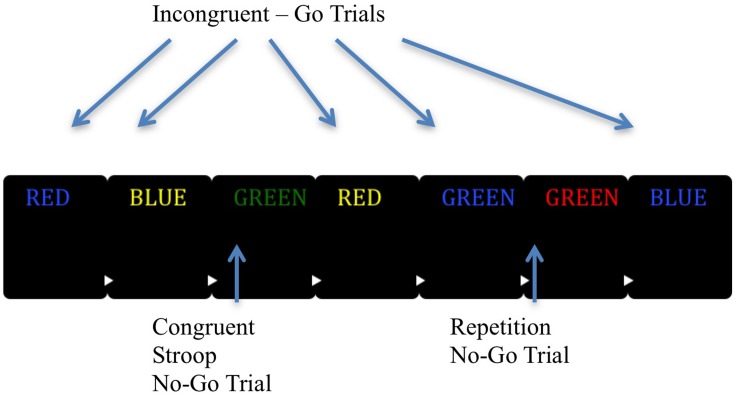
Graphic representation of the EAT task. The EAT presents a serial stream of single color words in incongruent fonts, with the word presented for 900 ms followed by a random inter-trial interval between 1000 and 1500 ms. Participants were trained to respond to each of the words with a single ‘Go trial’ button press, and withhold this response when either of two different circumstances arose. The first was if the same word was presented on two consecutive trials (Repeat No-go), and the second was if the word and color font of the word match (Congruent Stroop No-go). To indicate ‘error awareness’ participants were trained to press the error button on the trial following any commission errors. Adapted from “Neural Mechanisms Involved in Error Processing: A Comparison of Errors Made With and Without Awareness,” by Hester et al. (2005).